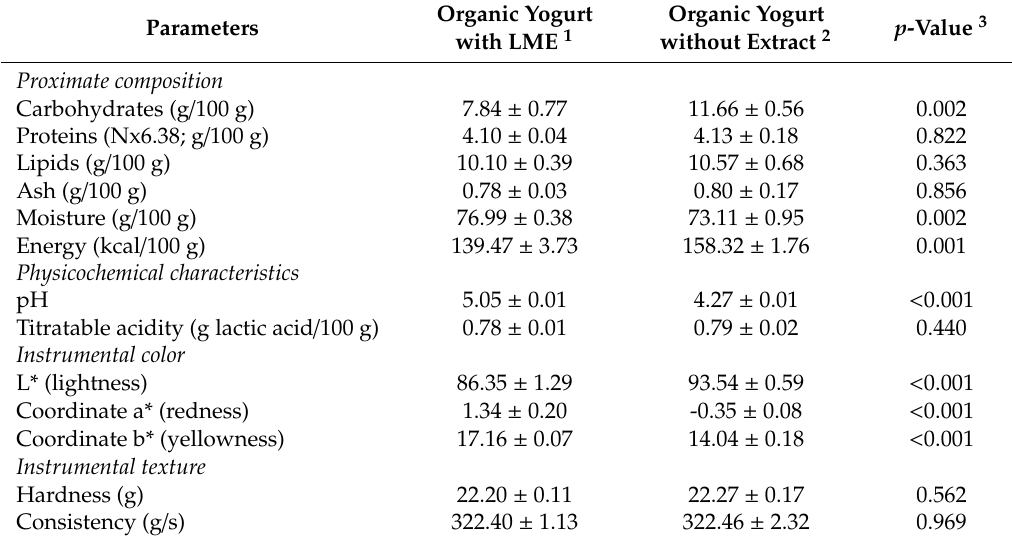
Table 7. Proximate composition, physicochemical characteristics, instrumental color, and texture of organic yogurts with and without the lyophilized marigold extract (LME).